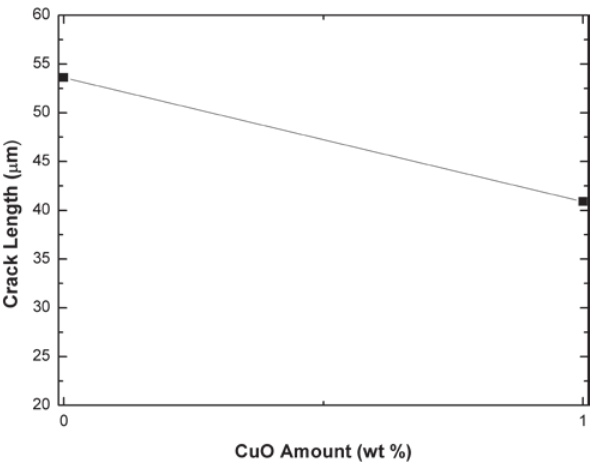
Fig. 3: The change of indentation-crack length as a function of CuO